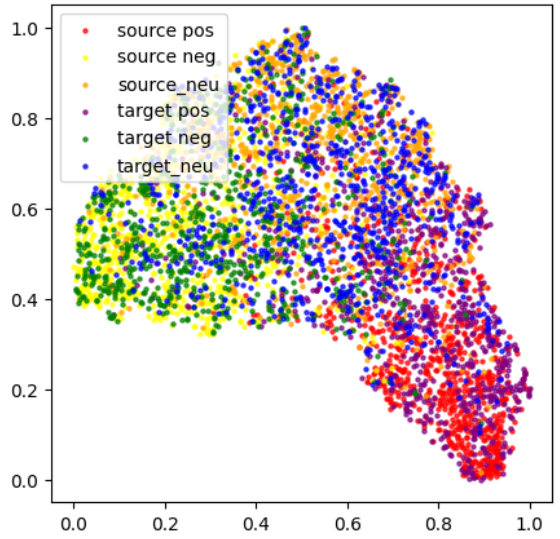
Figure 4. Visualization of feature representation on BT →